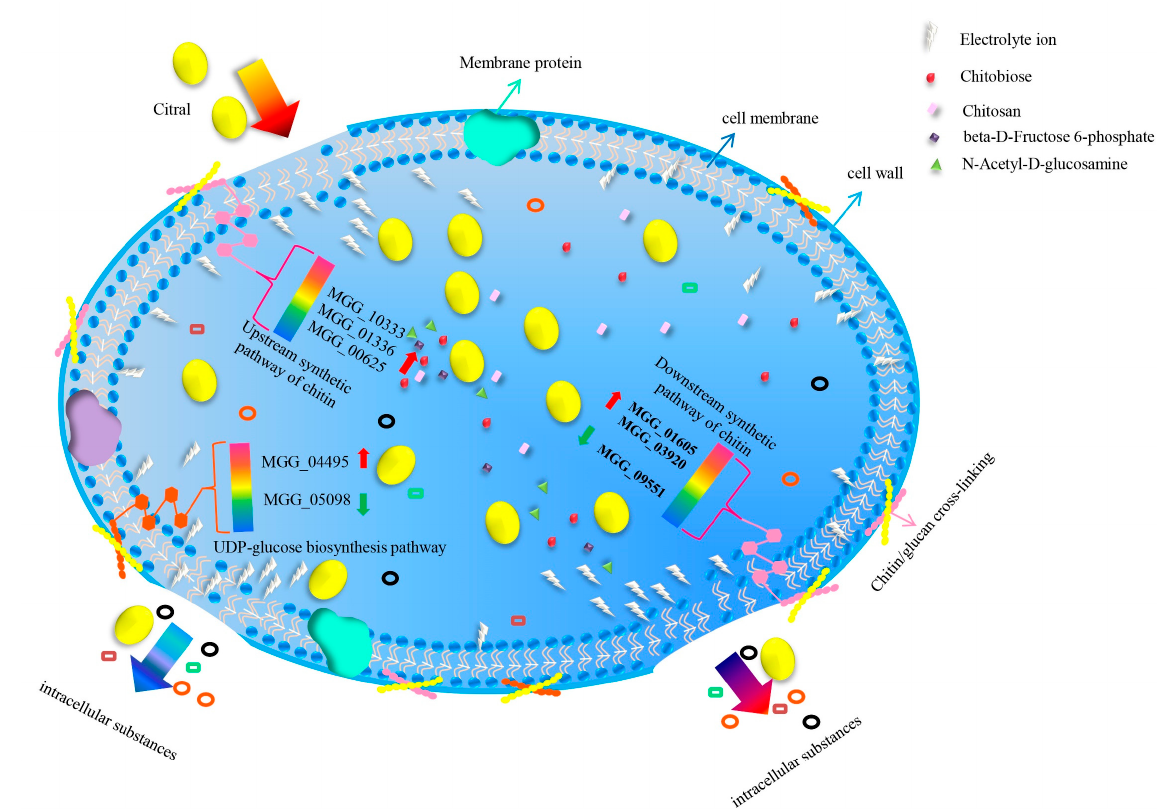
Figure 7. Model diagram illustrating the citral’s mechanism against the cell wall of M. oryzae